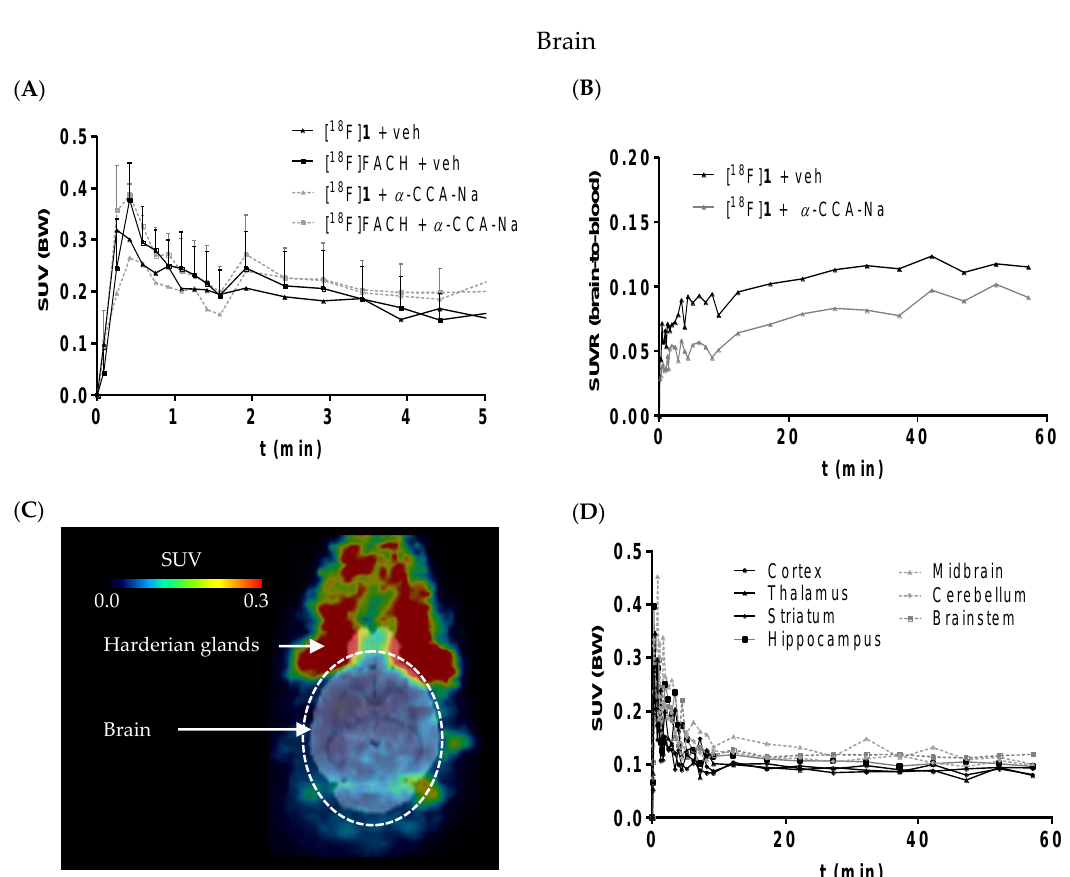
Figure 7. ( A ) Time-activity curve of [ 18 F] 1 (n = 1) and [ 18 F]FACH (n = 3) representing the SUVs without and with pre-administration of α -CCA-Na; ( B ) The SUVR of [ 18 F] 1 showing the brain to blood uptake ratio (n = 1); ( C ) horizontal section of representative PET image (averaged time frames from 0–60 min p.i.) of mouse head; ( D ) SUVs of di ff erent brain regions over time after injection of [ 18 F] 1 .